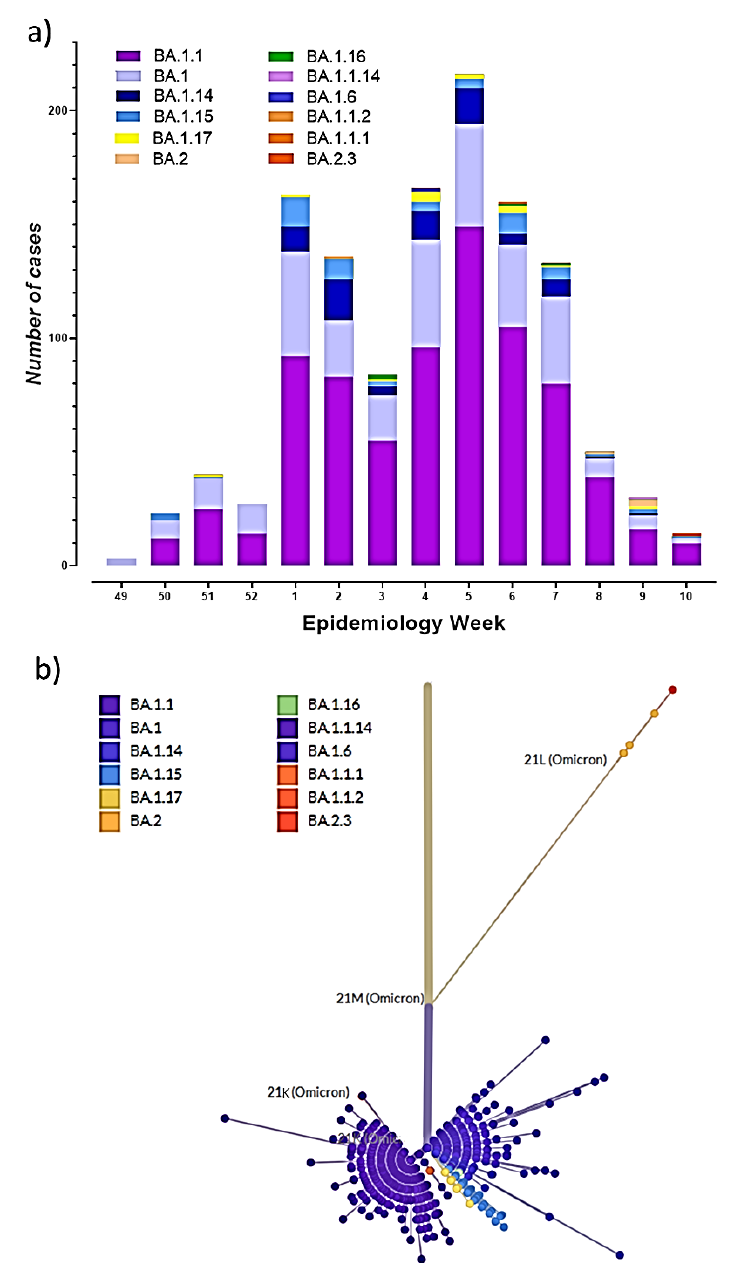
Figure 2. Omicron sub-lineages (BA.1.1.529 + BA.*) in Ecuador. ( a ) Sub-lineages by epidemiological week, ( b ) phylogenetic tree of all lineages.